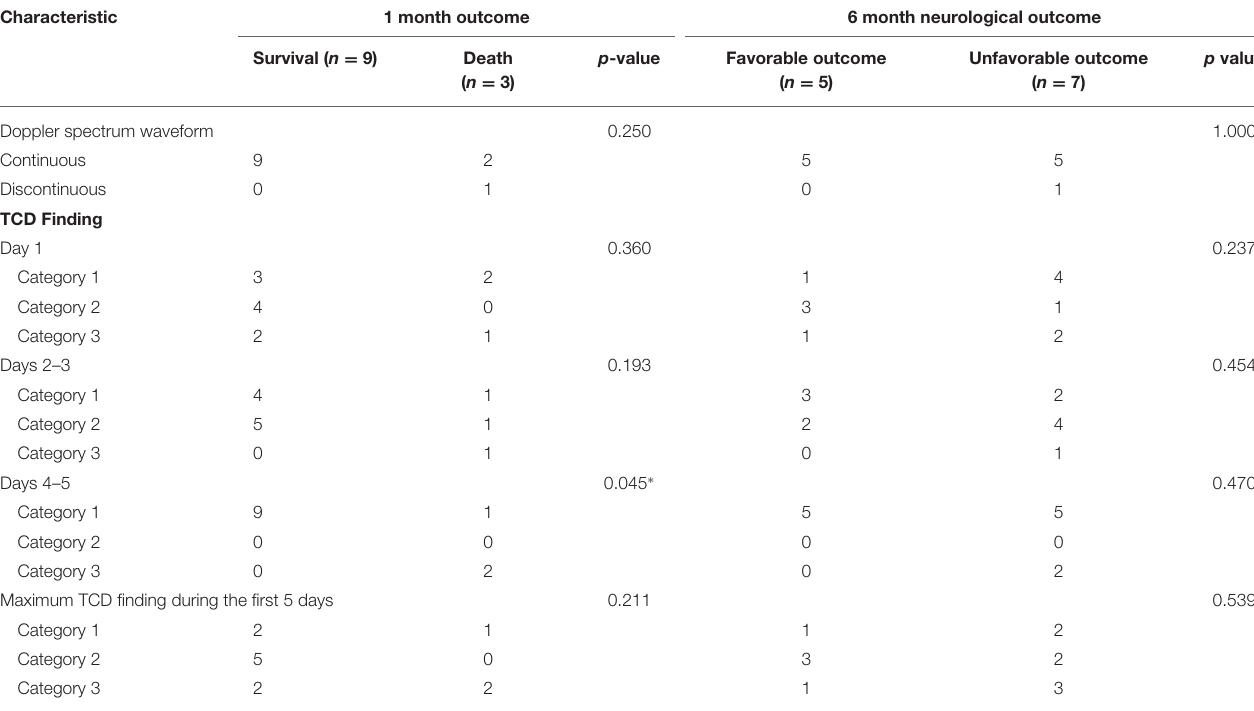
TABLE 2 | The parameters of the middle cerebral artery during different time points in 12 patients receiving point-of-care transcranial Doppler ultrasound guided cerebral resuscitation protocol. Characteristic 1 month outcome